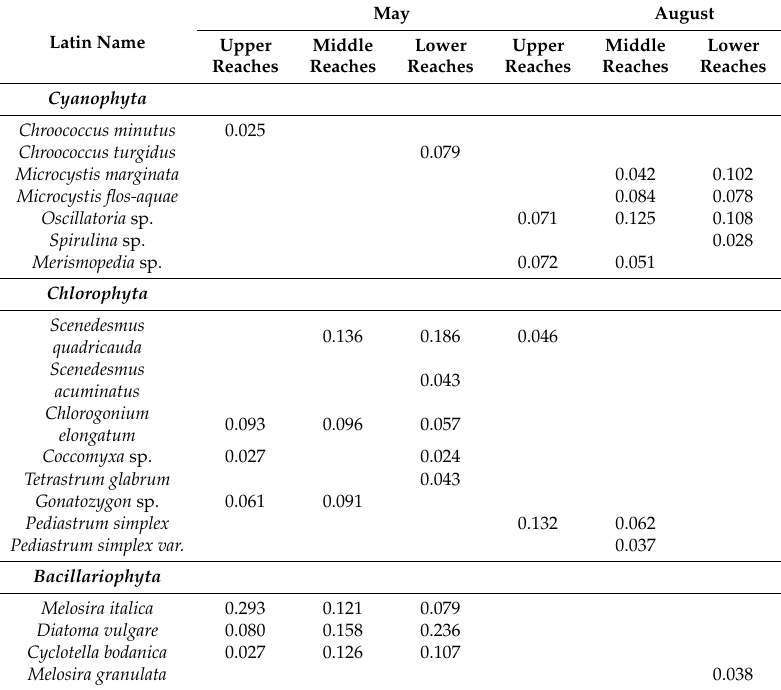
Table 1. Dominant species of